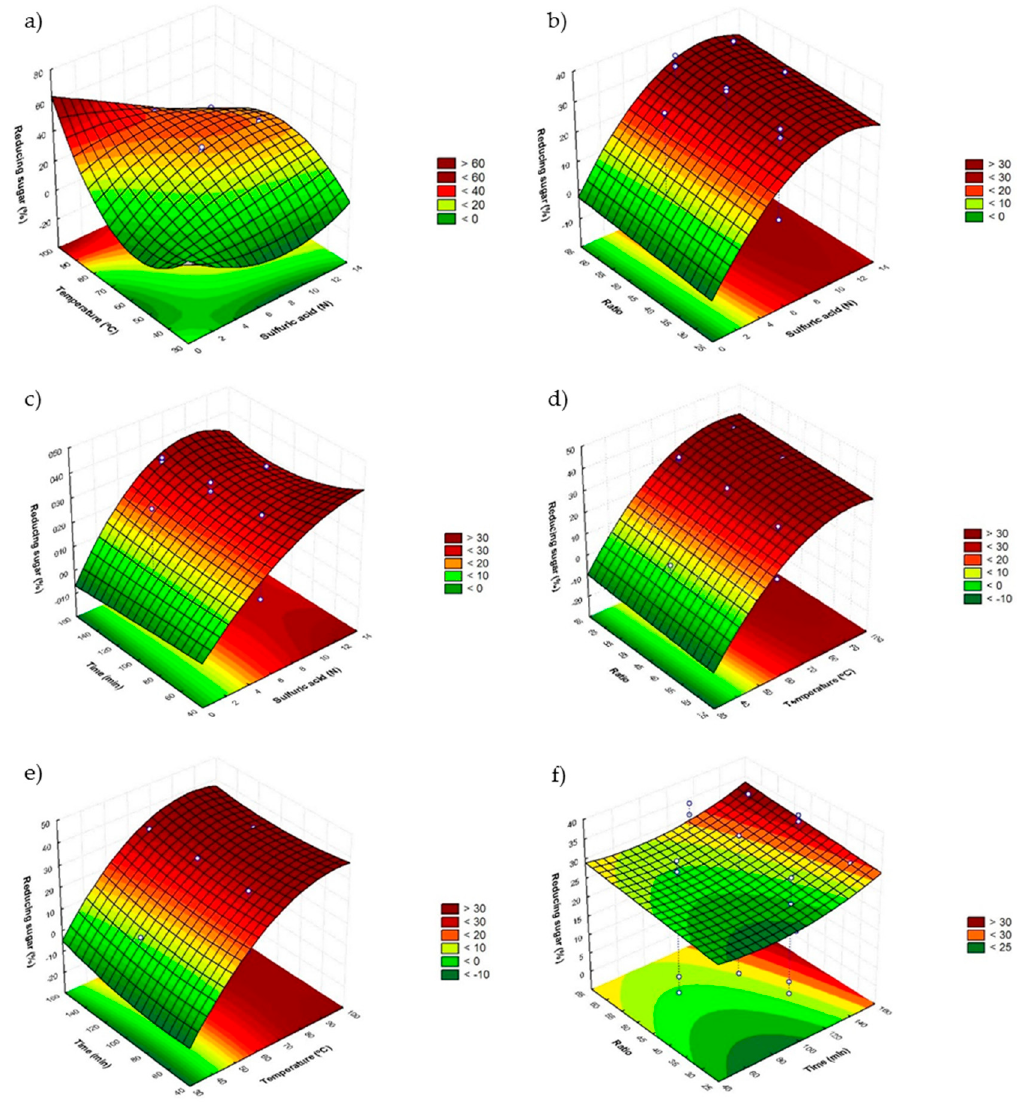
Figure 1. Response surface graphs ( a – f ) showing the combined effects of the process variables: H 2 SO 4 concentration (N), temperature (°C), time (min) and ratio (H 2 SO 4 /sample).